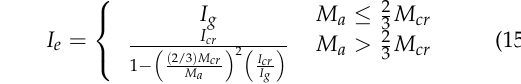
Fig. 3. Transformed rectangular cracked-section of RC beams are to be multiplied by an amplified factor (0.4+fy/690) in SI units or (0.4+fy/7000) in cm-kg metric units [11] to reflect possible slender member effects caused by lower amount of steel reinforcements [1, 4].